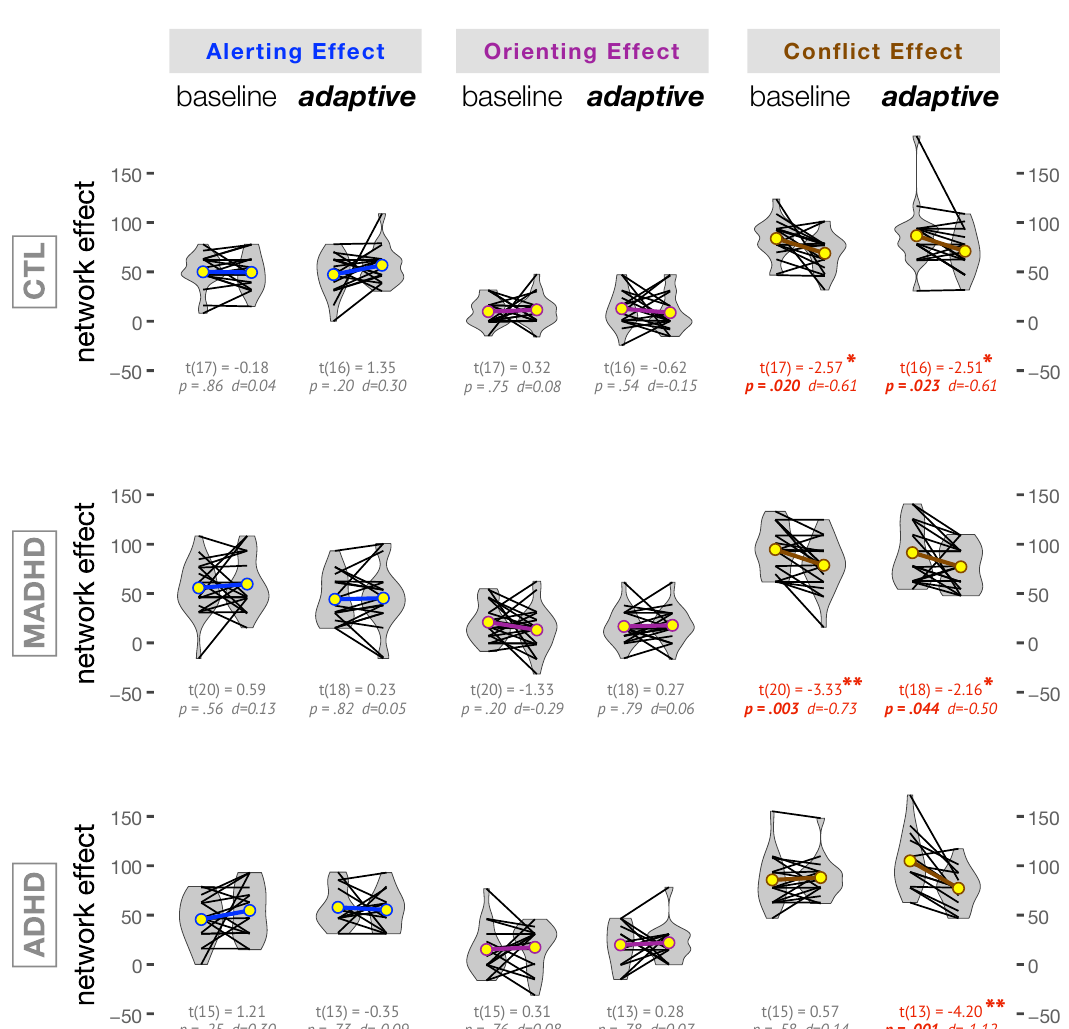
Figure 5. Attention network effects within groups before and after training. The yellow circles in the violin plots correspond to the average values of the corresponding network effects. The p -values and Cohen’s d effect sizes are reported for paired Student’s t tests. Notice that WMT affected only the conflict network. In particular, for ADHD only the adaptive training provoked a large and significant effect. Groups: CTL : control subjects; MADHD : patients with medication; ADHD : patients without medication